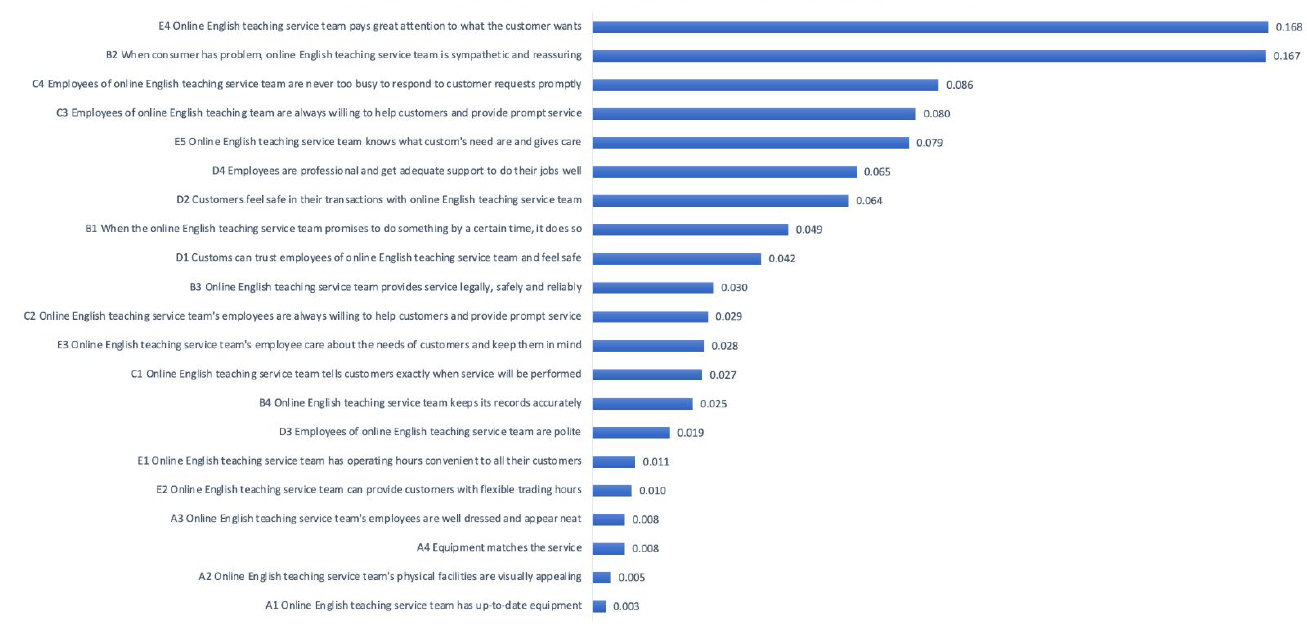
Figure 5. Indicators that were ordered by weight from the perspective of consumers. As shown in Figure 4, the top two weights of indicators under the influence of inter- dependence among the indicators from comprehensive opinions of service providers are